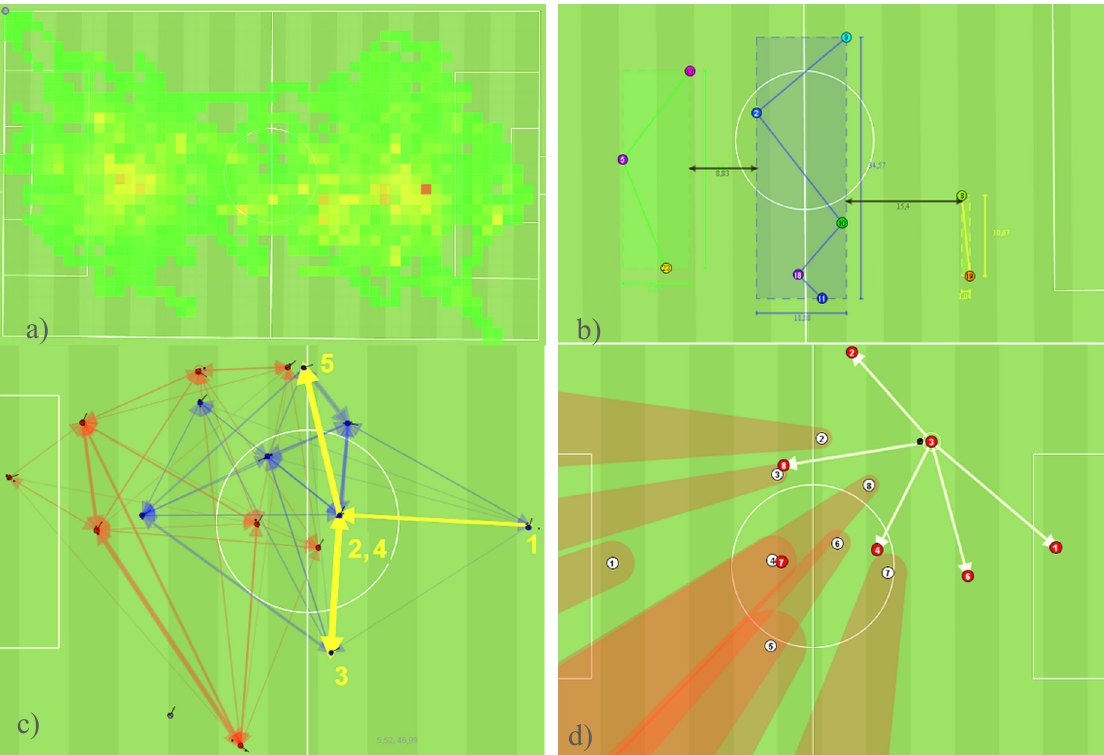
Figure 2. Four analysis tasks from different complexity levels: ( a ) a player’s heat map; ( b ) the team parts and distances in between; ( c ) pass sequence patterns (the yellow numbers represent the order of passing players) and ( d ) the passing possibilities of a ball possessing player (the black dot is the ball, possible passes are marked via white arrows).